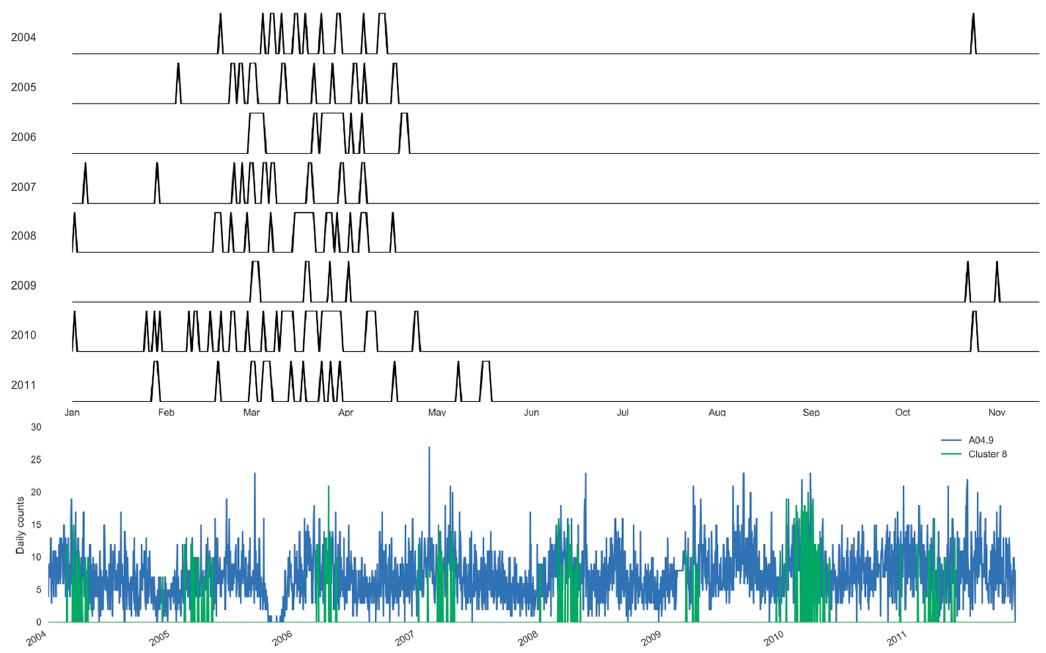
Figure 8. Sampling distribution of days selected annually and the corresponding time series for Cluster 8 of enteritis, A04.9 (Set 1) in Barnaul, Russia in 2004–2011.